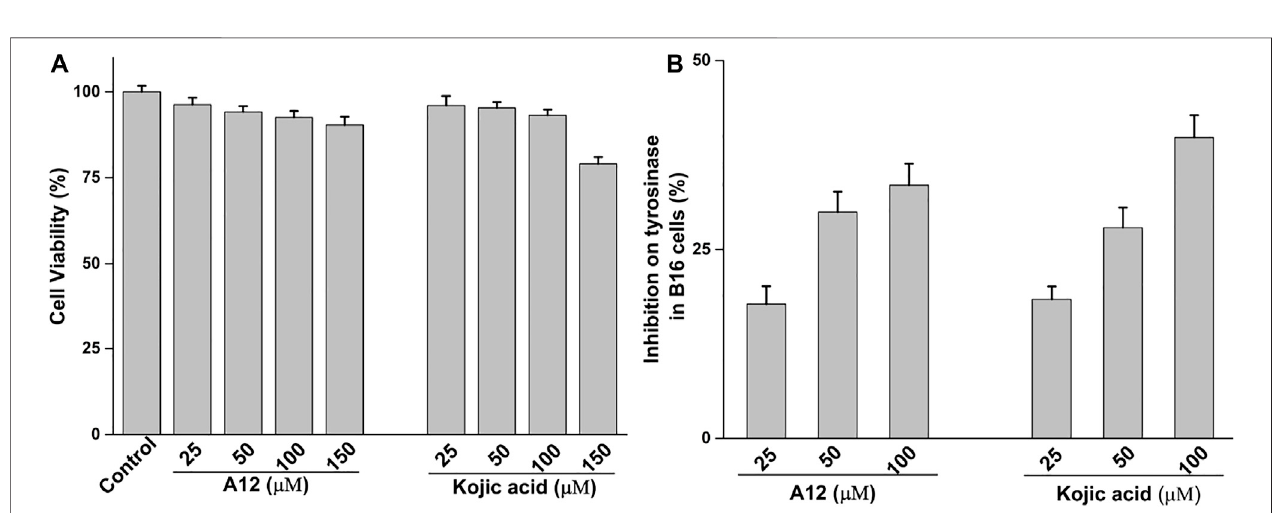
FIGURE 4 | (A) Cell cytotoxicityof A12 and kojic acid (B) and inhibition of cell tyrosinase activity of A12.